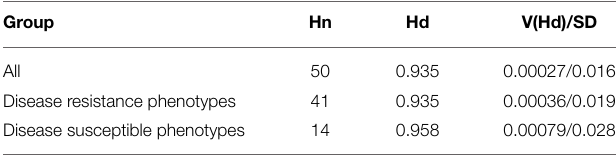
TABLE 3 | Summary statistics of haplotype diversity in Pi54 alleles. Group